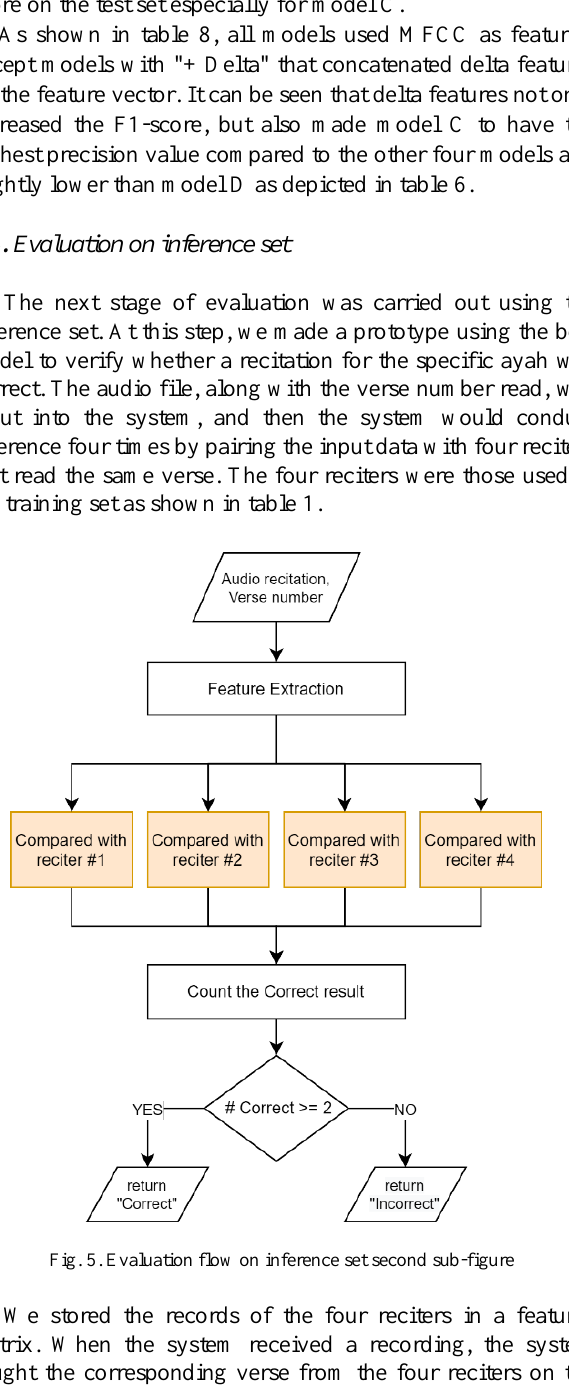
Table 8. Results comparison after using delta features on test set and inference set